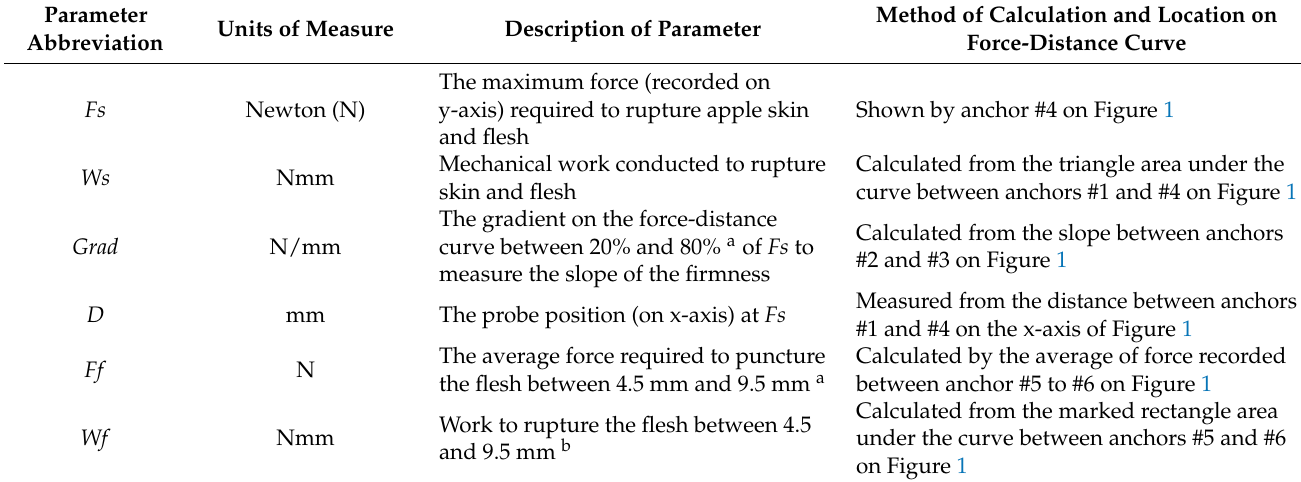
Table 1. List of instrumental parameters, abbreviations, and units of measurement associated with the instrumental measurements on the TA.XT plus Texture